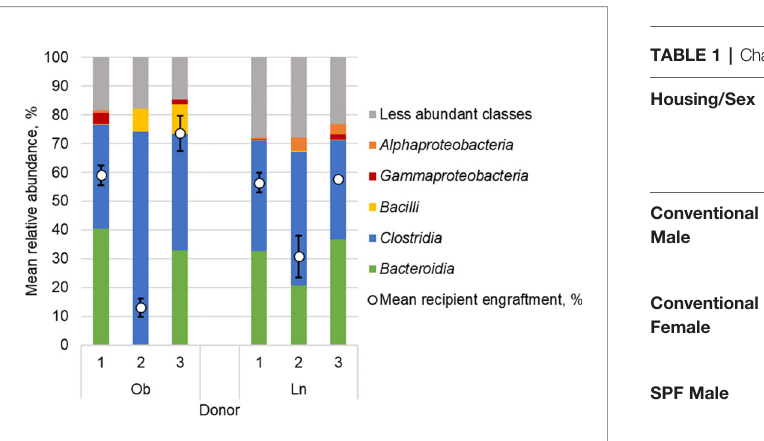
FIGURE 2 | Fecal microbial composition of obese (Ob) and lean (Ln) human donors represented as mean relative abundance (%) of predominant classes. White circles re fl ect percent similarity to donor microbiota within 1-week among all mice that received microbiota from each respective donor as determined by SourceTracker; values are mean ± standard deviation.